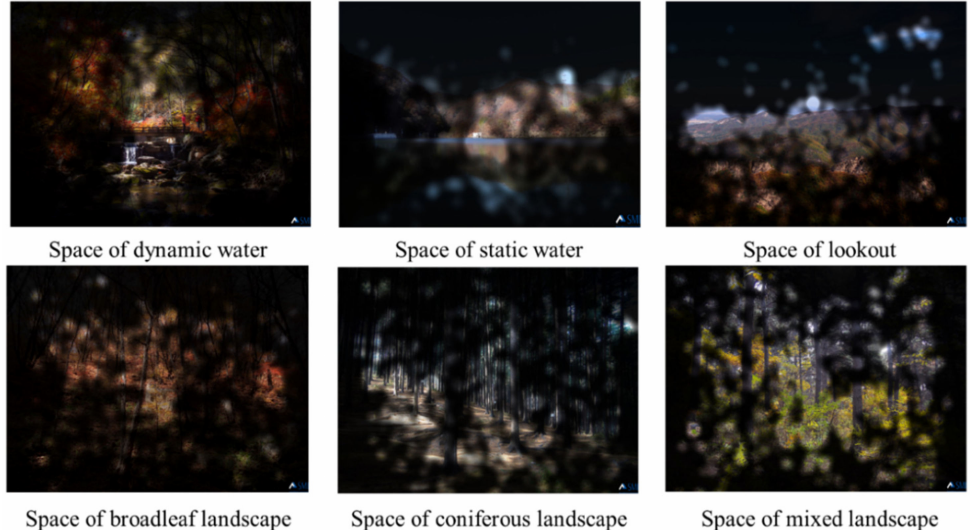
Figure 6. Focus map of different forest recreation landscape spaces. This figure was created by Yu Gao (Shenyang Agricultural